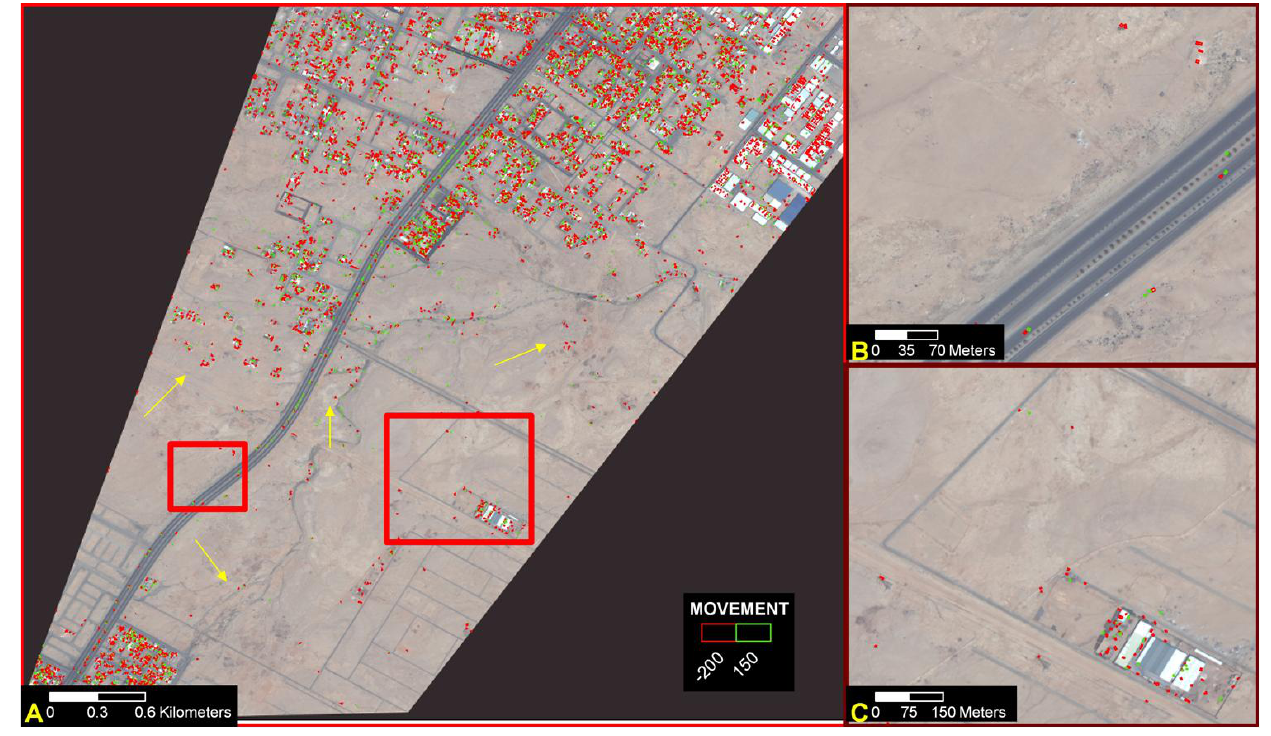
Figure 6. Desert imagery with 9380 movement polygons (A). Highway with movement pairs and some false-positives alongside (B) and a structure with many incorrect movement polygons with a movement-free perimeter (C).